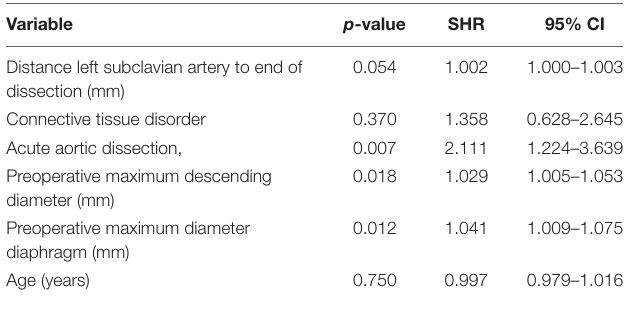
TABLE 4 | Competing risk regression: distal aortic